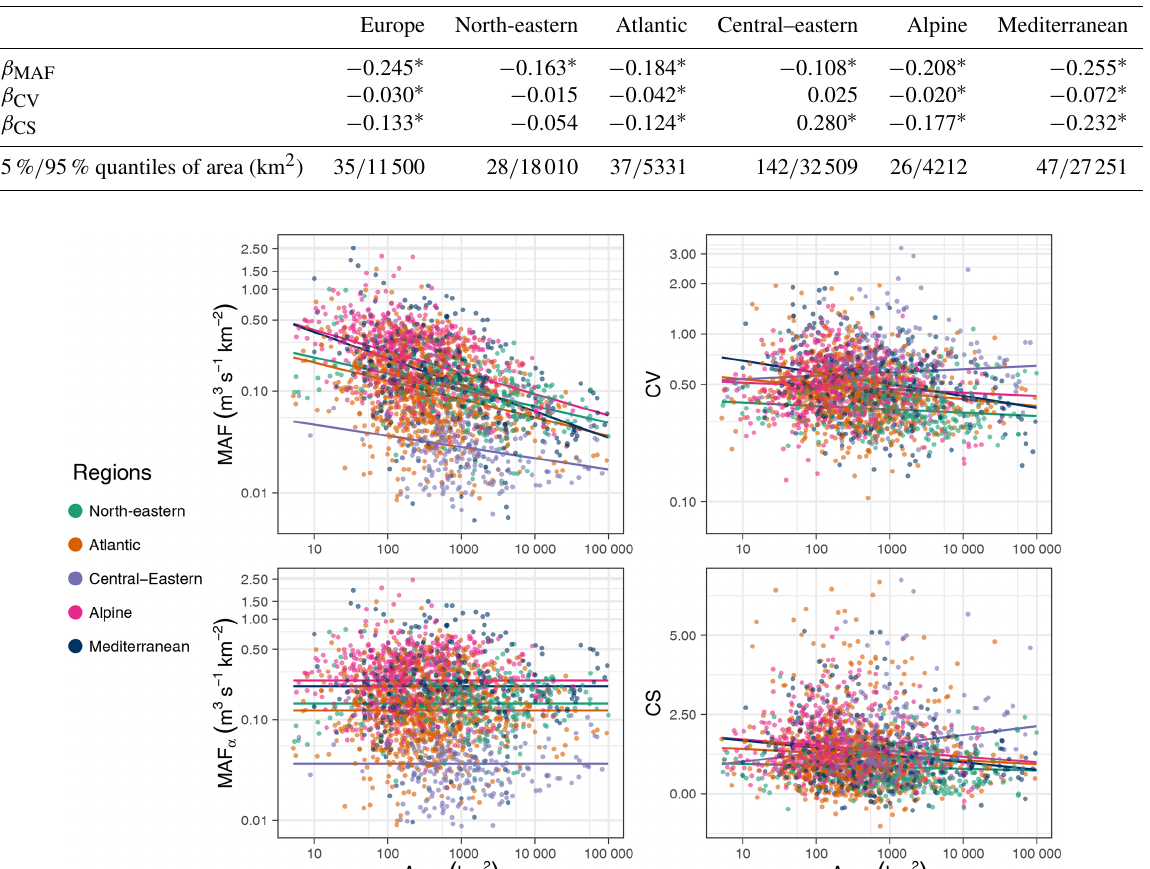
Table 3. Dependence of the flood moments with catchment area in a double-logarithmic relationship Eq. (5) and analogous equations for CV, and a semi-logarithmic relationship for CS, i.e. CS = log Aβ CS . The last lines show the 5% and 95% quantiles of catchment area (km 2 ). ∗ indicates statistical significance (two-sided t test) at the 5% level.